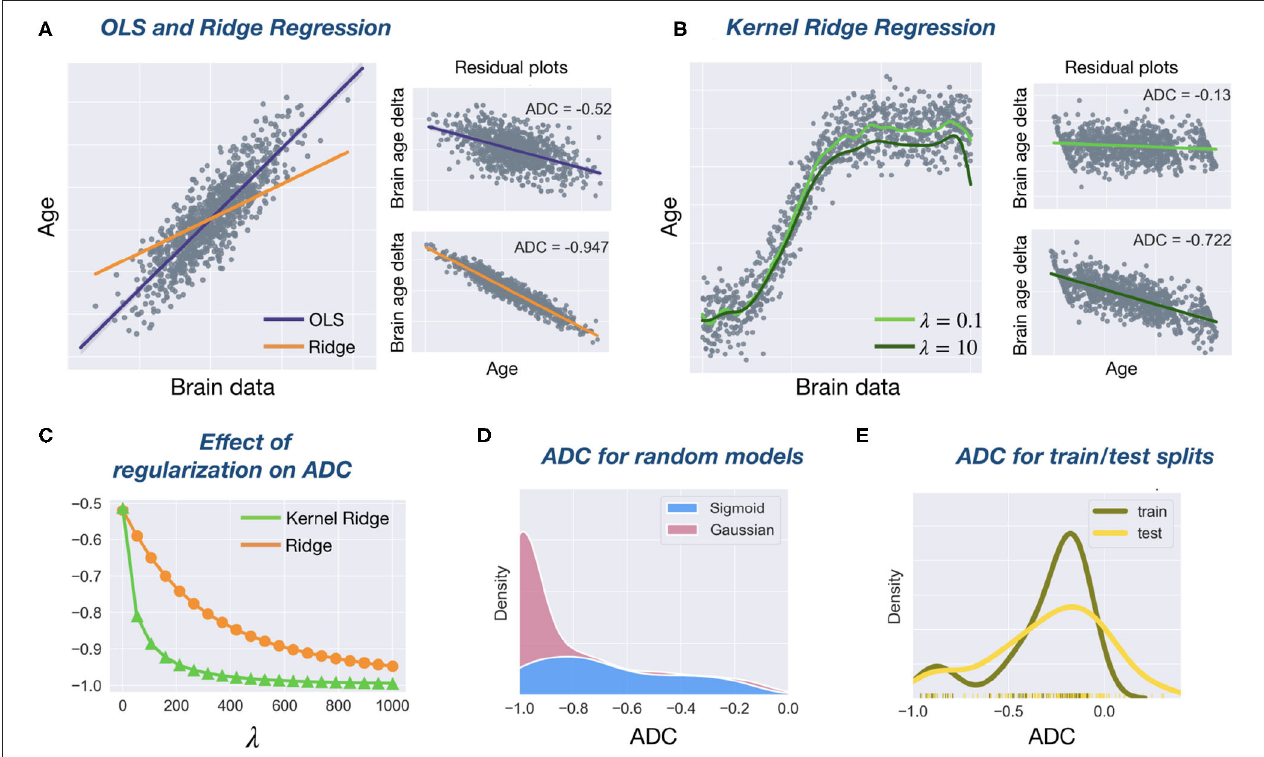
FIGURE 1 | Investigating age delta correlation (ADC) with simulated data. (A) Simulated data (1,000 samples, 1 feature, linear function, Gaussian noise) using Scikit-Learn’s make_regression function. Regression line fits for OLS and Ridge ( λ = 1,000) regression are shown. The small residual plots (plotting y vs. brain age delta) show a significant negative ADC for both models. (B) Simulated data (1,000 samples, 1 feature, sigmoid function, Gaussian noise) with two Kernel Ridge regression fits (RBF kernel, γ = 1) for two different regularization strengths λ . Again, residual plots show a high ADC. (C) For both Ridge and Kernel Ridge regression, increasing the regularization hyperparameter λ leads to more negative ADC. This effect is more pronounced for Kernel Ridge than Ridge. (D) ADC density plot. We sampled 100 random Gaussian and sigmoid datasets as specified before. We created random regression models by sampling slopes and intercepts from a uniform distribution (the sampling space included the OLS coefficients). When calculating ADCs on random models, a clear bias toward large negative ADC values is evident. Its distribution is more peaked for the Gaussian data. (E) ADC density plot. Simulated data (1,000 samples, 5 features, linear function, Gaussian noise) is split into 50% train, 50% test data. An OLS model is calculated on the train data and ADC is calculated on both train and test data. For the test data, the variability of the ADC is larger than for train data, and its mode is slightly more